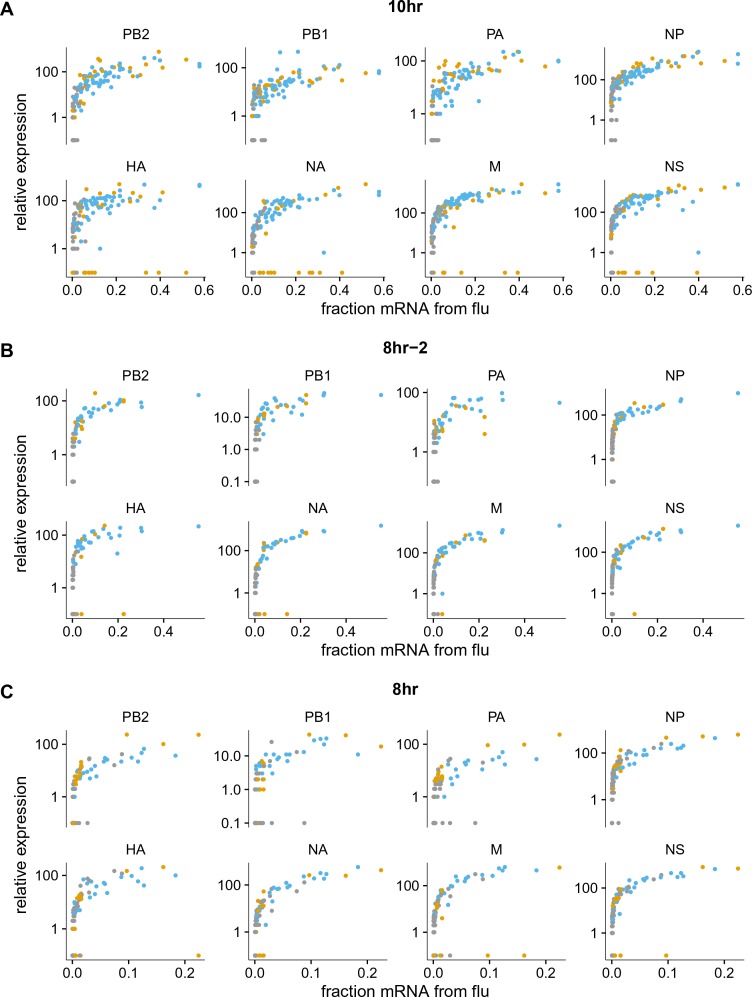
Like panel (A), but shows samples individually.The normalized expression of each viral gene as a function of the fraction of total mRNA derived from virus, shown for the 10 hr and 8 hr samples individually (the other samples had too few infected cells for this analysis to be useful). Points are colored as in Figure 5A.